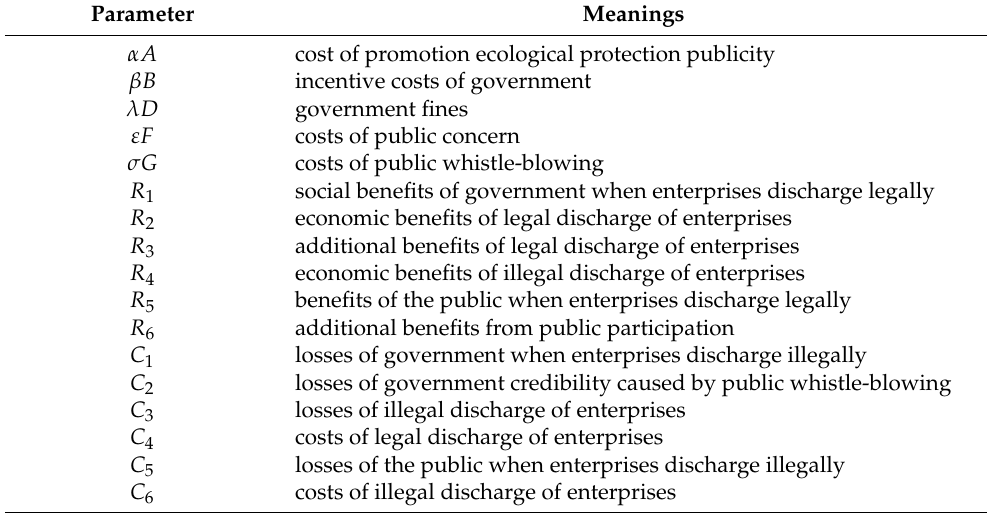
Table 1. Parameter symbols and their meanings.